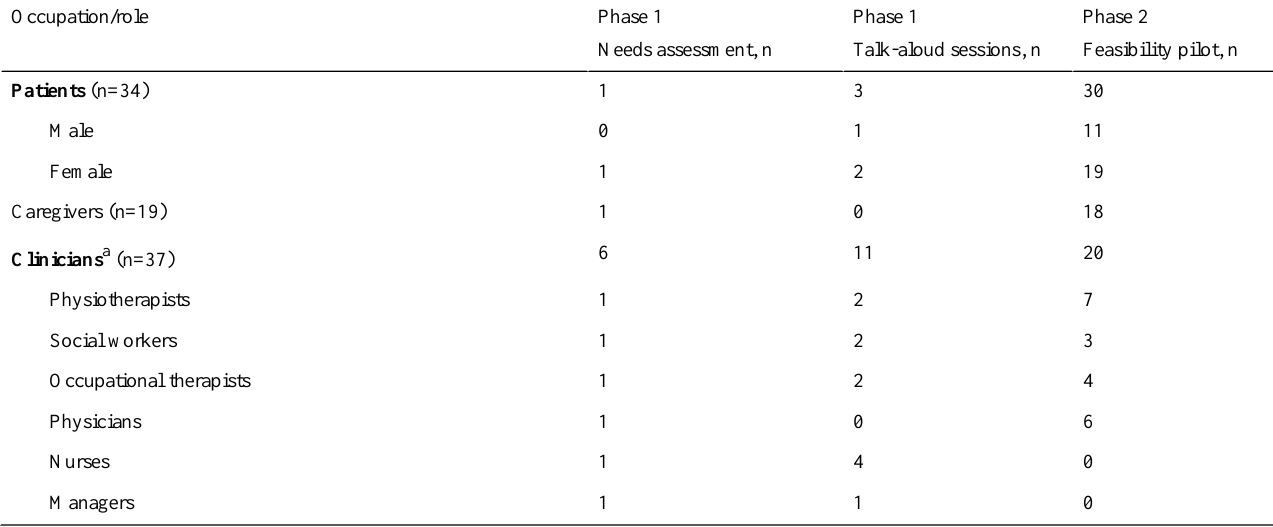
Table 1. Demographics of the study participants